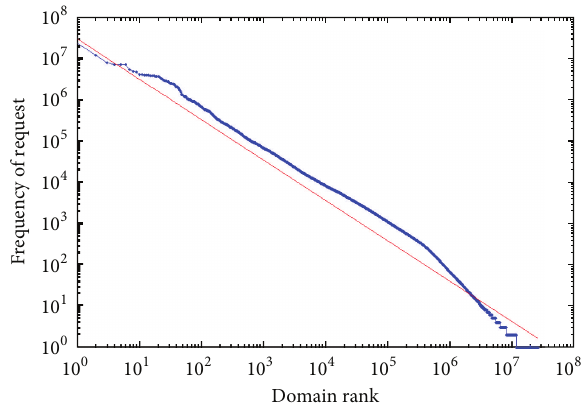
Figure 8: Popularity distribution of domain